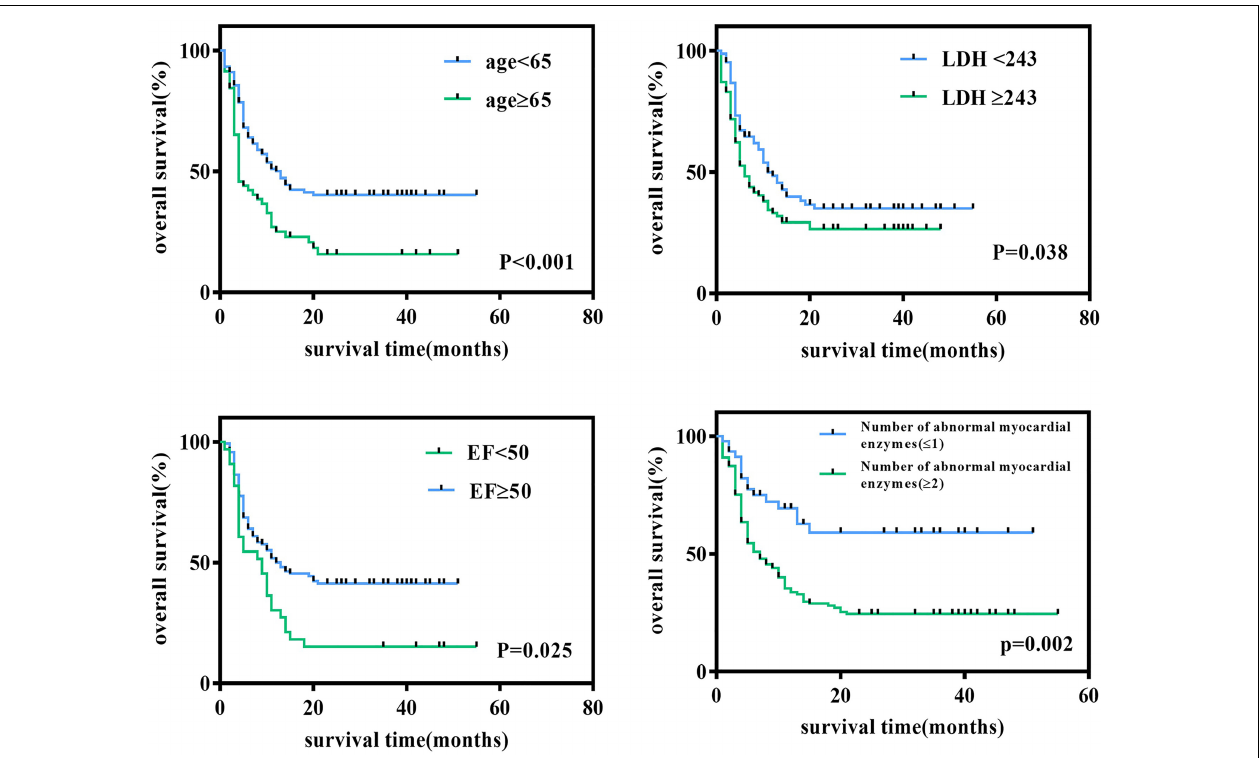
FIGURE 4 | Survival curve of newly diagnosed acute leukemia patients. Log-rank test for univariate analysis of heart-related indicators in newly diagnosed acute leukemia patients through Kaplan-Meier curves. LDH, lactate dehydrogenase; EF, ejection fraction.